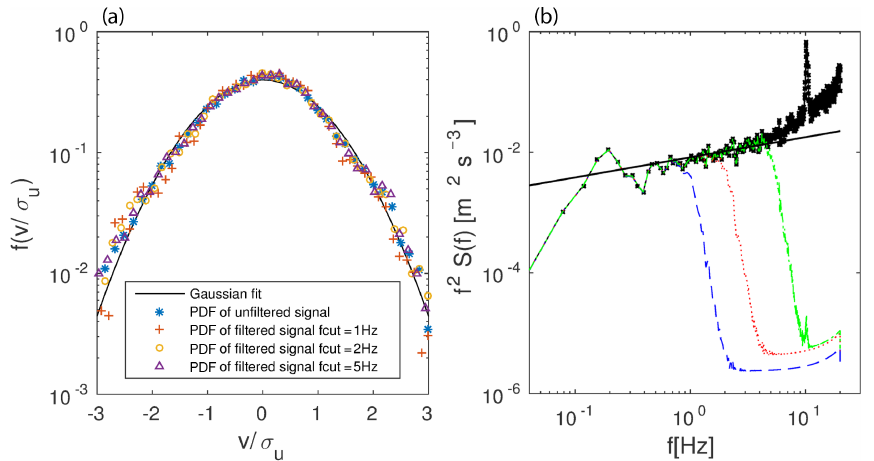
Figure 4. (a) PDFs of the normalized unfiltered and filtered measured signals compared with the normalized Gaussian curve. (b) Spectra f 2 S(f ) of the unfiltered signal (black line with symbols), signal filtered with f cut = 5Hz (green, solid line), signal filtered with f cut = 2Hz (red dotted line) and signal filtered with f cut = 1Hz (blue, dashed